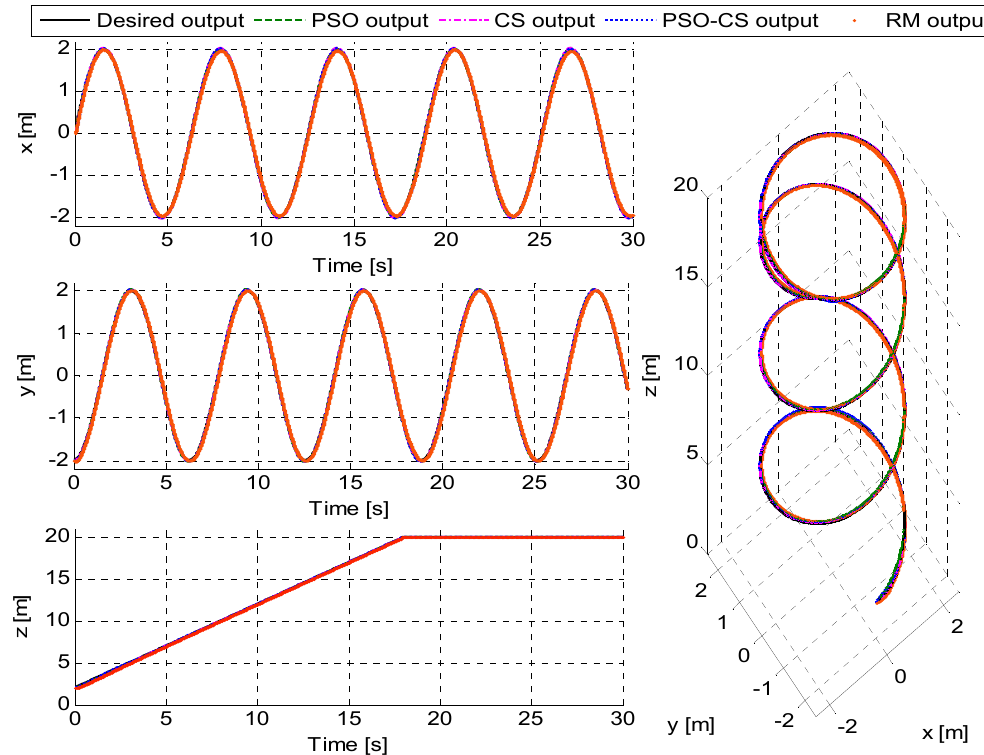
Figure 15. Quadrotor’s positions ( x , y , z ) using Particle Swarm Optimization (PSO), Cuckoo Search (CS), Particle Swarm Optimization-Cuckoo Search (PSO-CS), and Reference Model (RM) (helical trajectory).